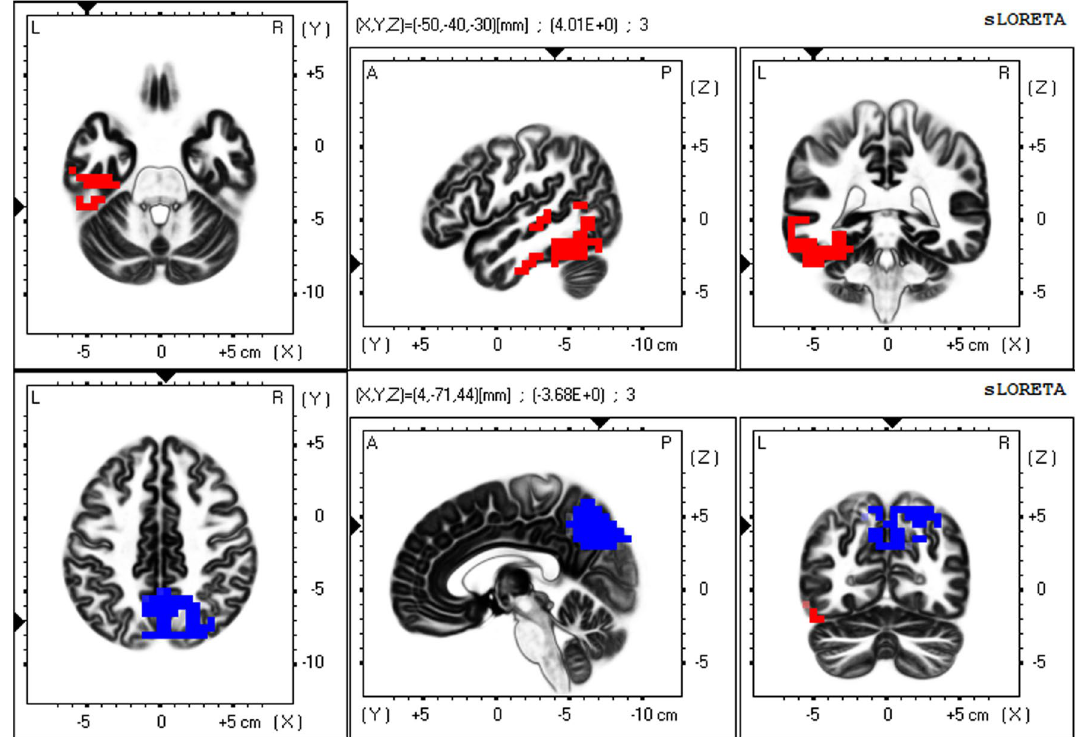
Figure 3. Memory network. The memory network is composed of alpha activity in the left temporal cortex with anti-correlated alpha activity in the precuneus. The upper row shows the left temporal alpha activity, and the lower row shows the precuneus alpha activity. In the colour–coded maps, red and blue colours represent power increase and decrease with increasing network activity, respectively. Slices from left to right are axial, sagittal and coronal images (viewed from top, left and back). L, left; R, right; A, anterior; P, posterior.